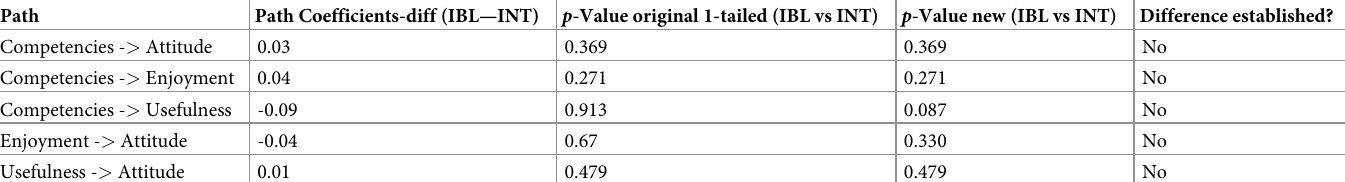
Table 10. PLS-MGA